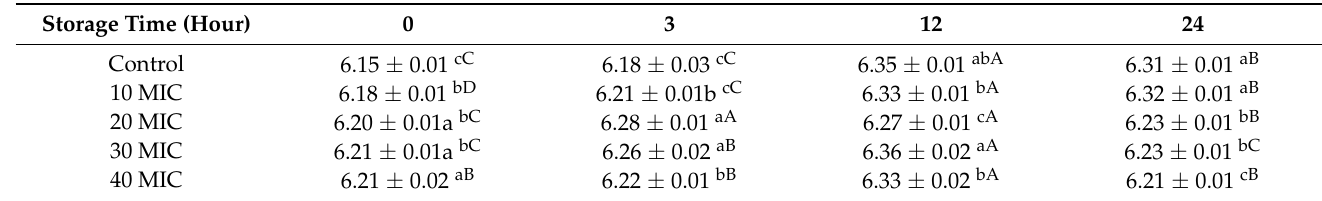
Table 2. pH values of raw chicken breast meat with OEO during storage at 10 ◦